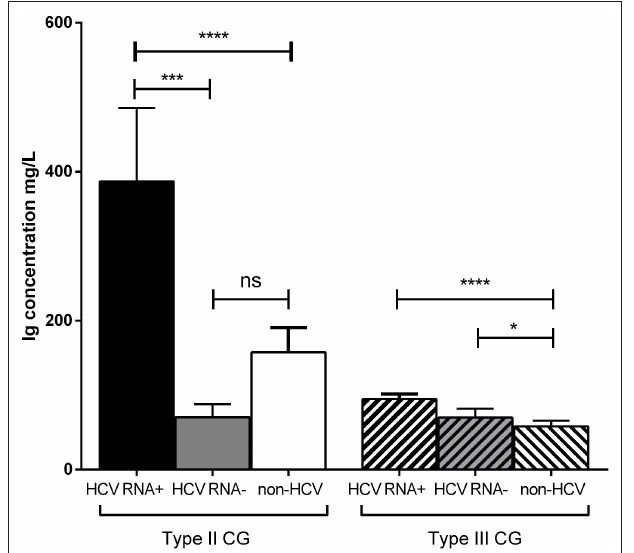
FIGURE 3 | Concentration of types II and III CG in HCV patients and non-HCV subjects. Three groups were compared: 272 HCV RNA + patients, 45 HCV RNA − patients, 355 non-HCV subjects (mean ± SEM, **** p < 0.0001, *** p = 0.001, * p = 0.03). ns, not significant.